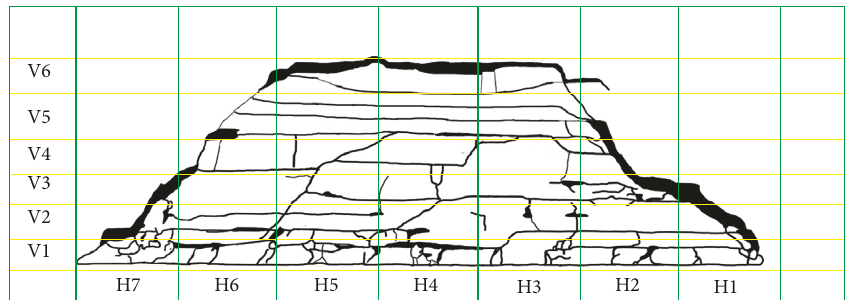
Figure 9: Schematic diagram for the fracture zones.